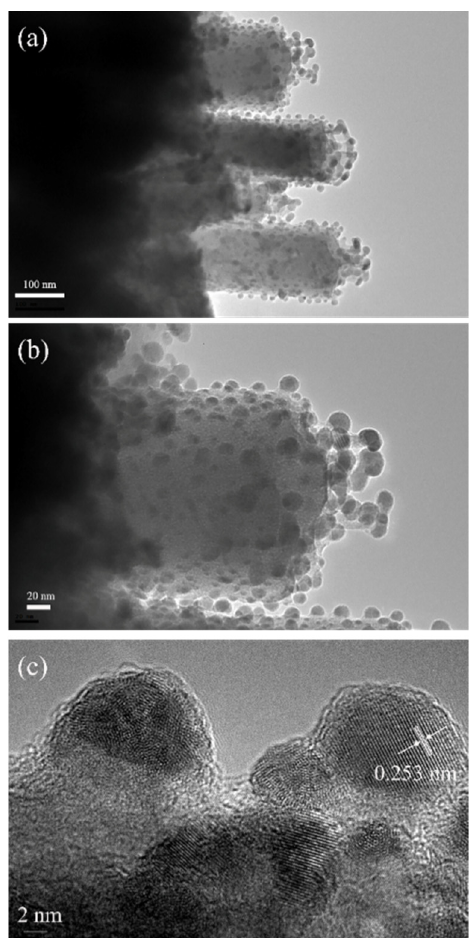
Figure 3. ( a )–( d ) SEM images of Ag 2 S/ZnO nanocomposites with different immersion time of 15, 30, 45, and 60 min, re- spectively.